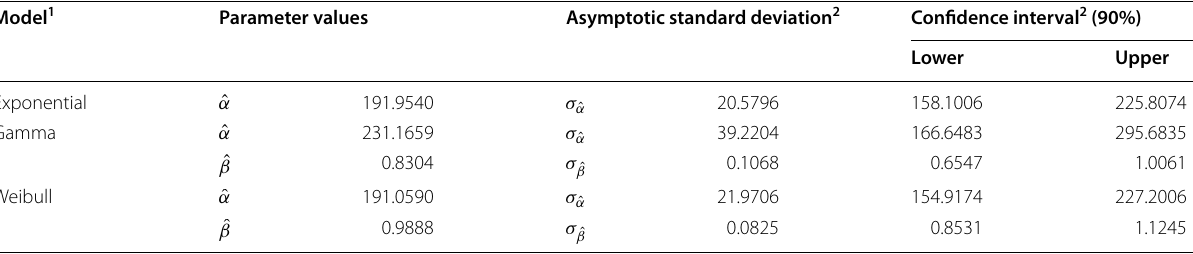
1 For the exponentiated exponential model, the parametric uncertainties cannot be computed as the trigamma function ψ ′ (β − 1 ) is not defined for ˆ β < 1 (see Pasari and Dikshit 2015, 2015a, 2015b; Pasari 2018) 2 For the computation of asymptotic standard deviation and 90% confidence interval of the model parameters, we followed a surrogate approach of Fisher Information Matrix and associated Cramer–Rao lower bound theorem (see Pasari and Dikshit 2015, 2015a, 2015b; Pasari 2018)